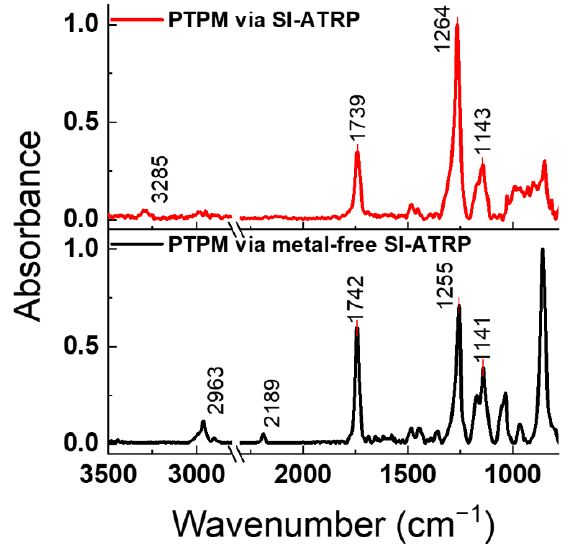
Figure 2. Normalized FTIR spectra of PTPM brushes synthesized via SI-ATRP and metal-free SI- ATRP. The spectra are normalized for clarity due to low absorbance intensity observed for the thin PTPM brushes prepared via classical SI-ATRP.